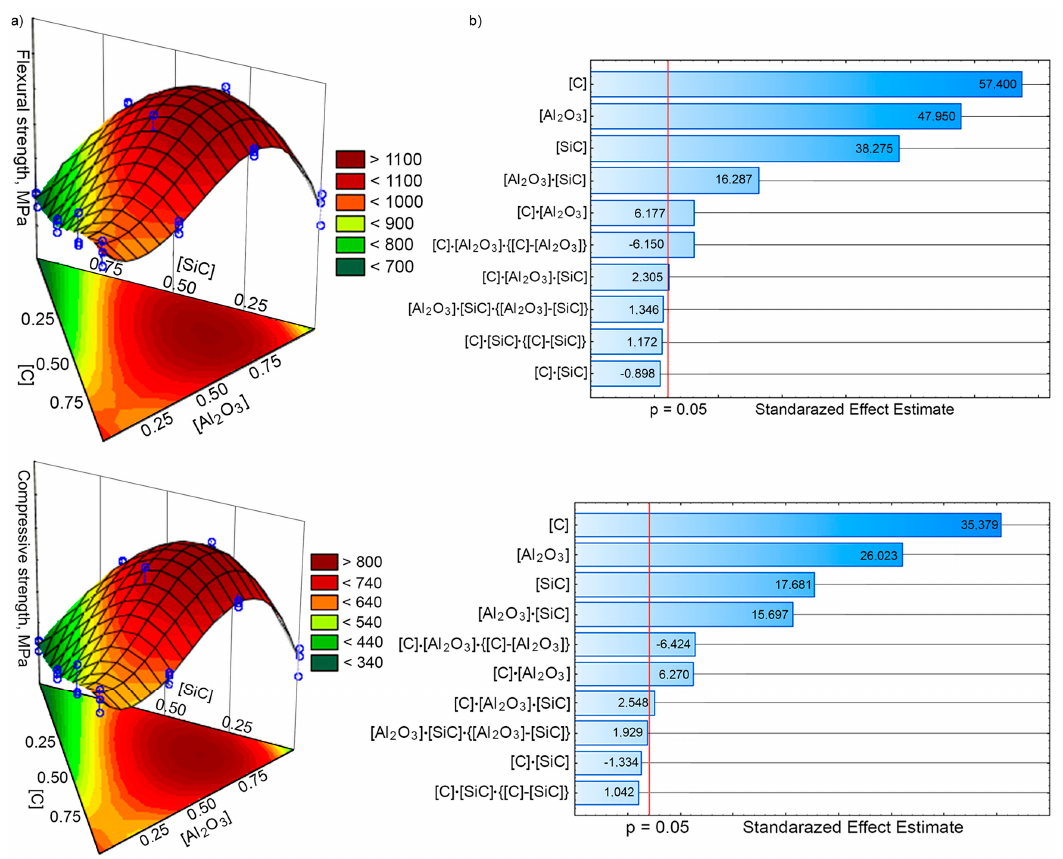
Figure 7. The influence of nanoadditives content on the strength of MMCs tested: ( a ) 3D functions and isoplates; ( b ) Pareto charts.